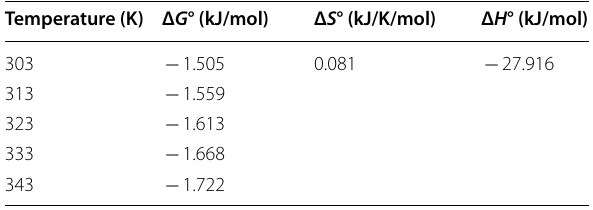
Table 6 Thermodynamic parameters for Cr (VI) bioreduction by Tamarindus indica methanol leaves extract at pH